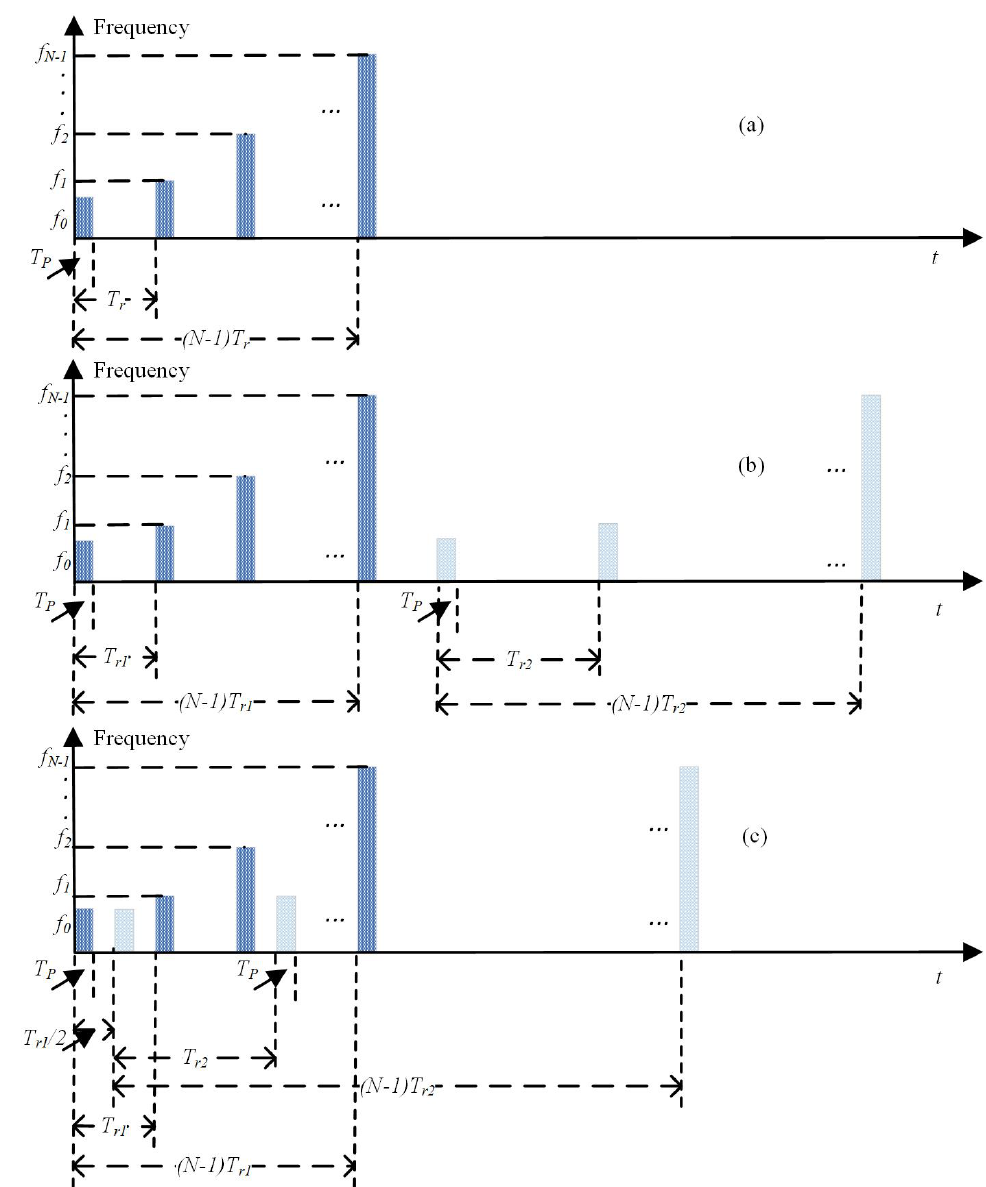
Figure 2. Normal SF, sequentially transmitted DSF, and cross-transmitted DSF waveforms. ( a ) Normal SF waveform. ( b ) Sequentially transmitted DSF waveform. ( c ) Cross-transmitted DSF